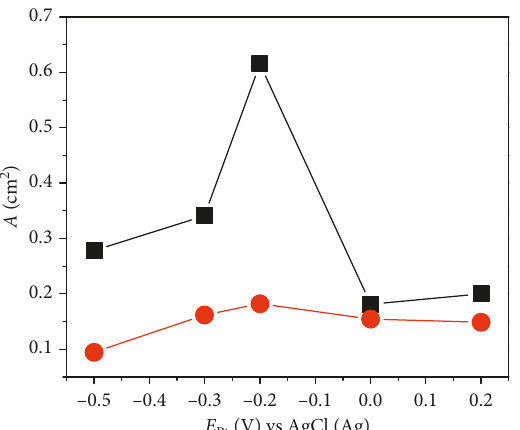
Figure 6: Effect of Pt electrodeposition potential on active surface area obtained from hydrogen desorption peaks ( ) and ferricyanide reduction peaks (